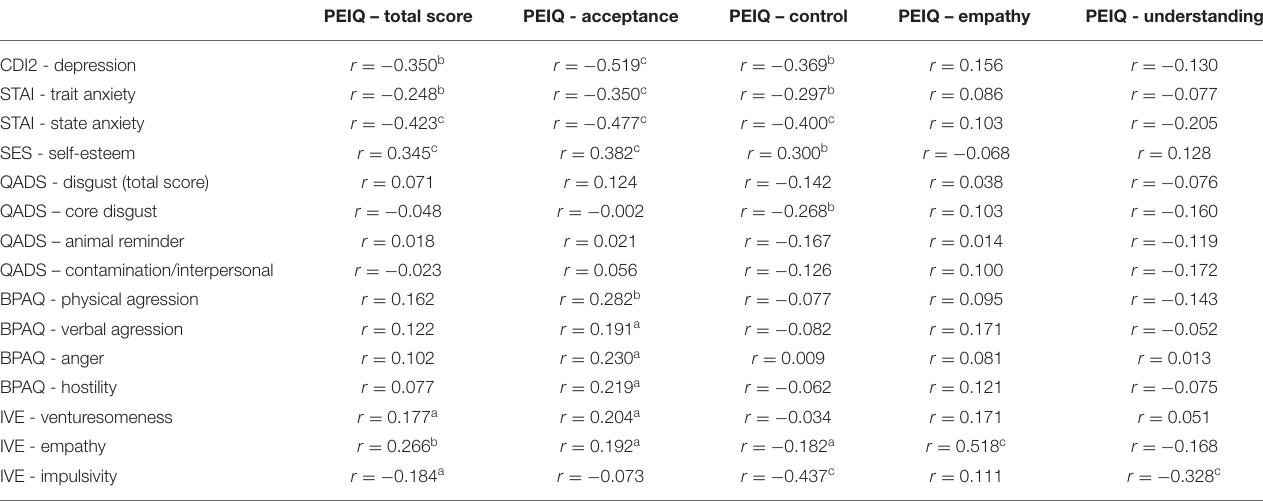
TABLE 2 | Correlations between the level of emotional intelligence and other measures recorded in this study. PEIQ – total score PEIQ - acceptance PEIQ – control PEIQ –